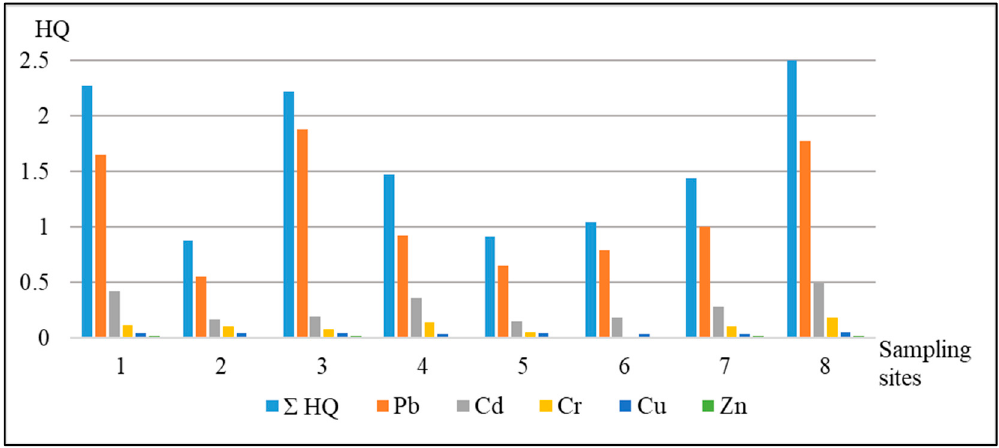
Figure 6. Estimation of the non-carcinogenic risk for the group of adult population.